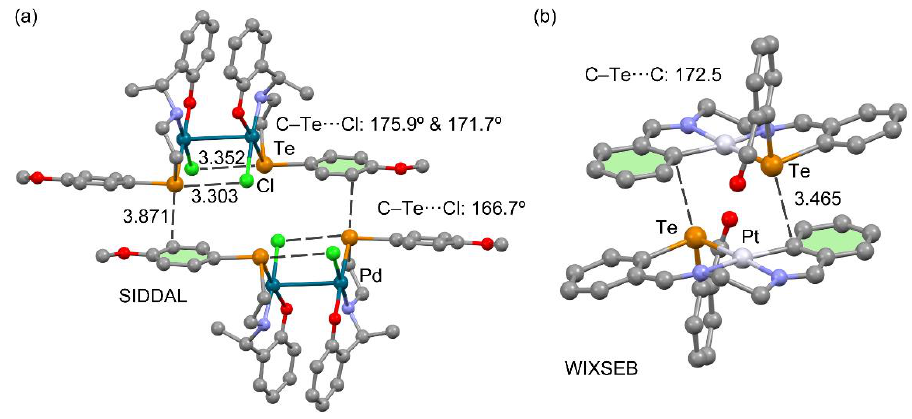
Figure 13. Partial views of the X-ray structures of refcodes SIDDAL ( a ) and WIXSEB ( b ). Distances in Å . H-atoms omitted for clarity.